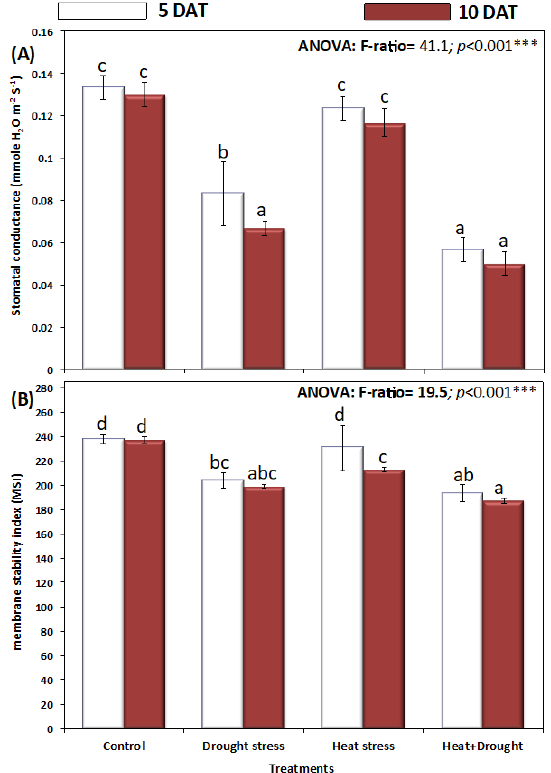
Figure 5. ( A–B ) Effect of drought, heat, and interaction between drought and heat stresses on ( A ) stomatal conductance and ( B ) membrane stability index (MSI) of A. sieberi alba. Data expressed as mean of triplicates, error bars represent standard error for means. Means marked with different letters are significantly different according to ANOVA and DMRTs at p < 0.05.